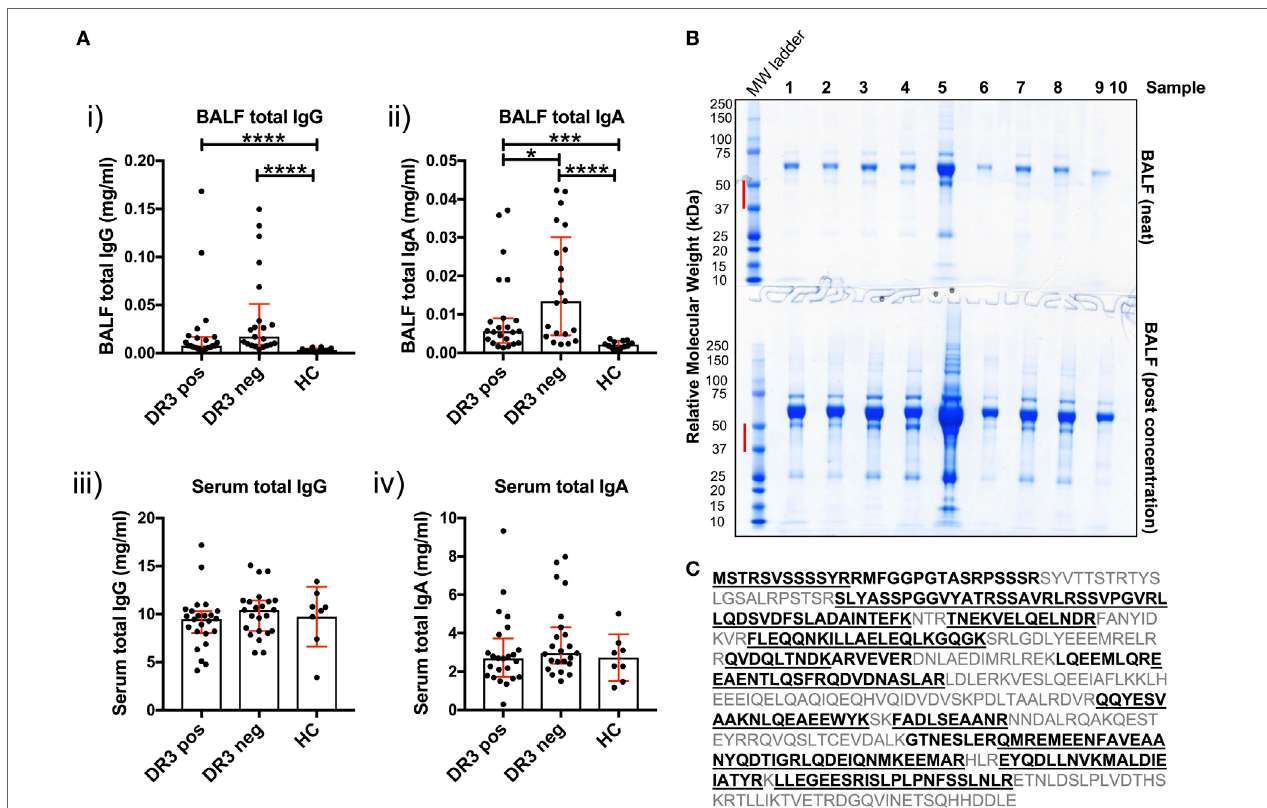
FigUre 4 | Soluble IgG, IgA, and extracellular vimentin in bronchoalveolar lavage fluid (BALF). The respective total IgG and IgA concentrations of all BALF samples [ (a) i–ii] were first determined by ELISA, and compared to serum concentrations [ (a) iii–iv]. Data comparisons performed using the non-parametric Mann–Whitney U test. Values are presented as median with interquartile range, * p < 0.05; ** p < 0.01; *** p < 0.001; and **** p < 0.0001. Selected samples were subsequently concentrated by size-exclusion chromatography, or left neat and resolved on 4–12% Bis-Tris-gels by reducing SDS-PAGE (B) . The molecular weight range (red bar) for each of the lanes of Coomassie-stained gels was excised for each sample. Relative molecular weights as determined by the molecular weight ladder (far left lane) are indicated (kDa). All vimentin peptides determined by mass spectrometry are highlighted in emboldened black, and those confirmed to > 97% probability underlined (c) . BALF samples run on SDS-PAGE gels were from HLA-DRB1*03 + (samples 1–4), HLA-DRB1*03 − patients (samples 5–8), and one healthy control (sample 9). Lane 10 served as a negative control (Laemmli buffer alone). Mass spectrometry and protein concentration data for the respective patient samples are provided in the Supplementary